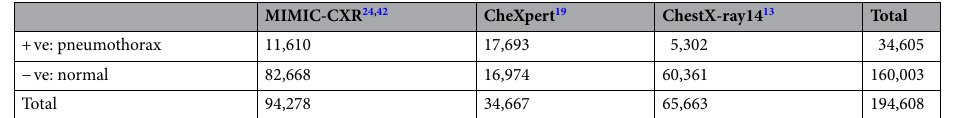
Table 1. A summary of chest X-ray images in the Dataset 1 through combination of three public datasets.